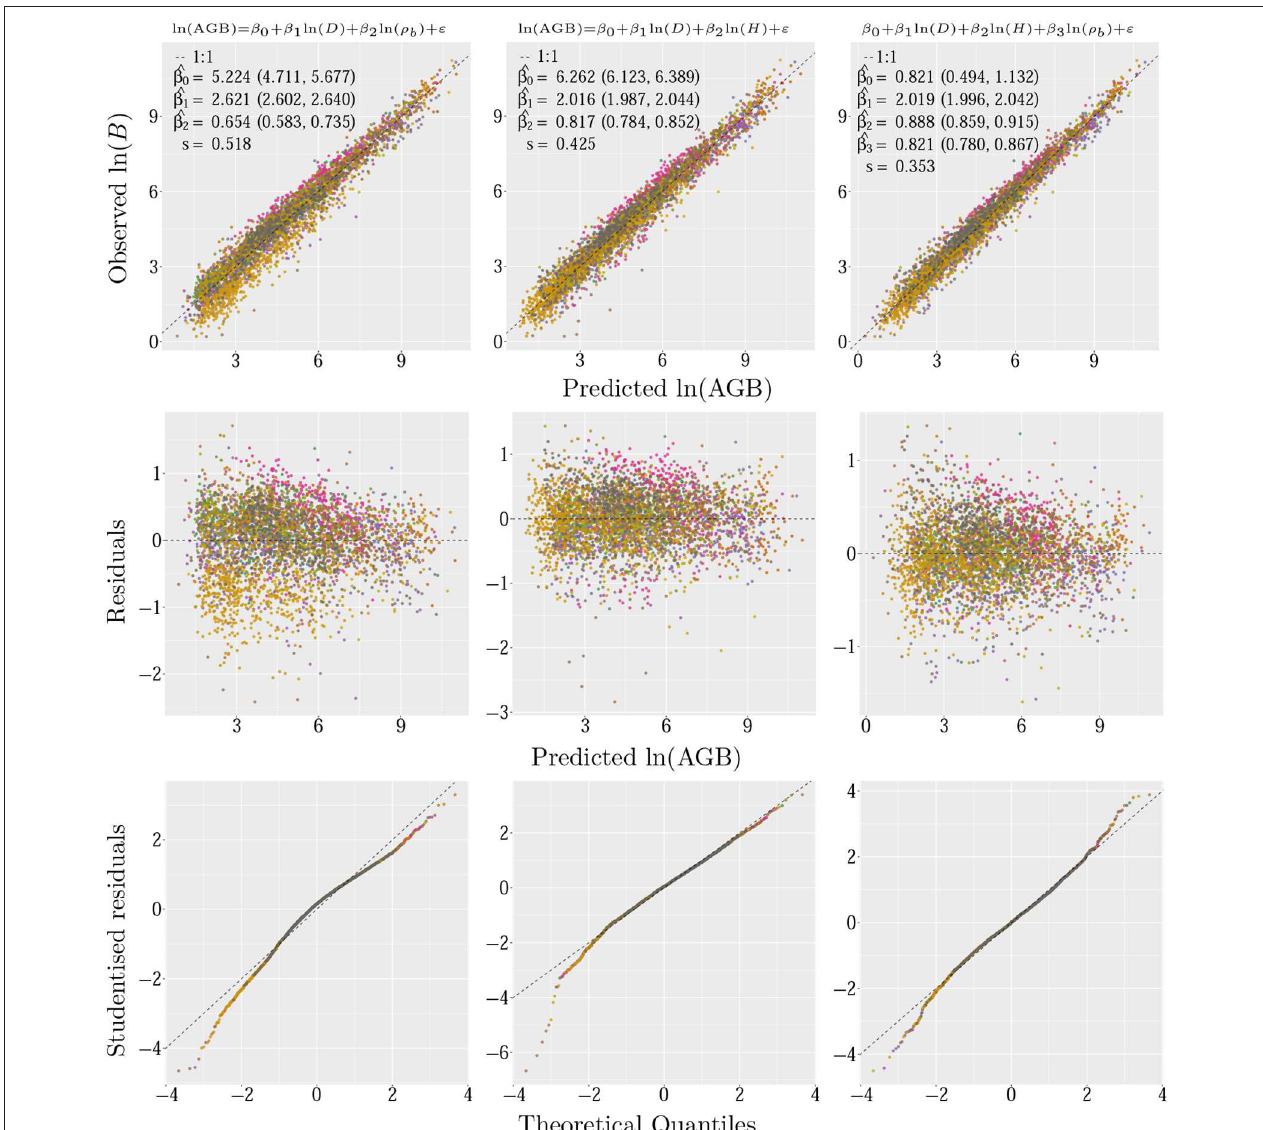
FIGURE 4 | The three considered multivariate pan-tropical model forms. Format is consistent with Figure 3 . Similar to the bivariate models, residuals exhibit heteroscedasticity and are non–normally distributed.